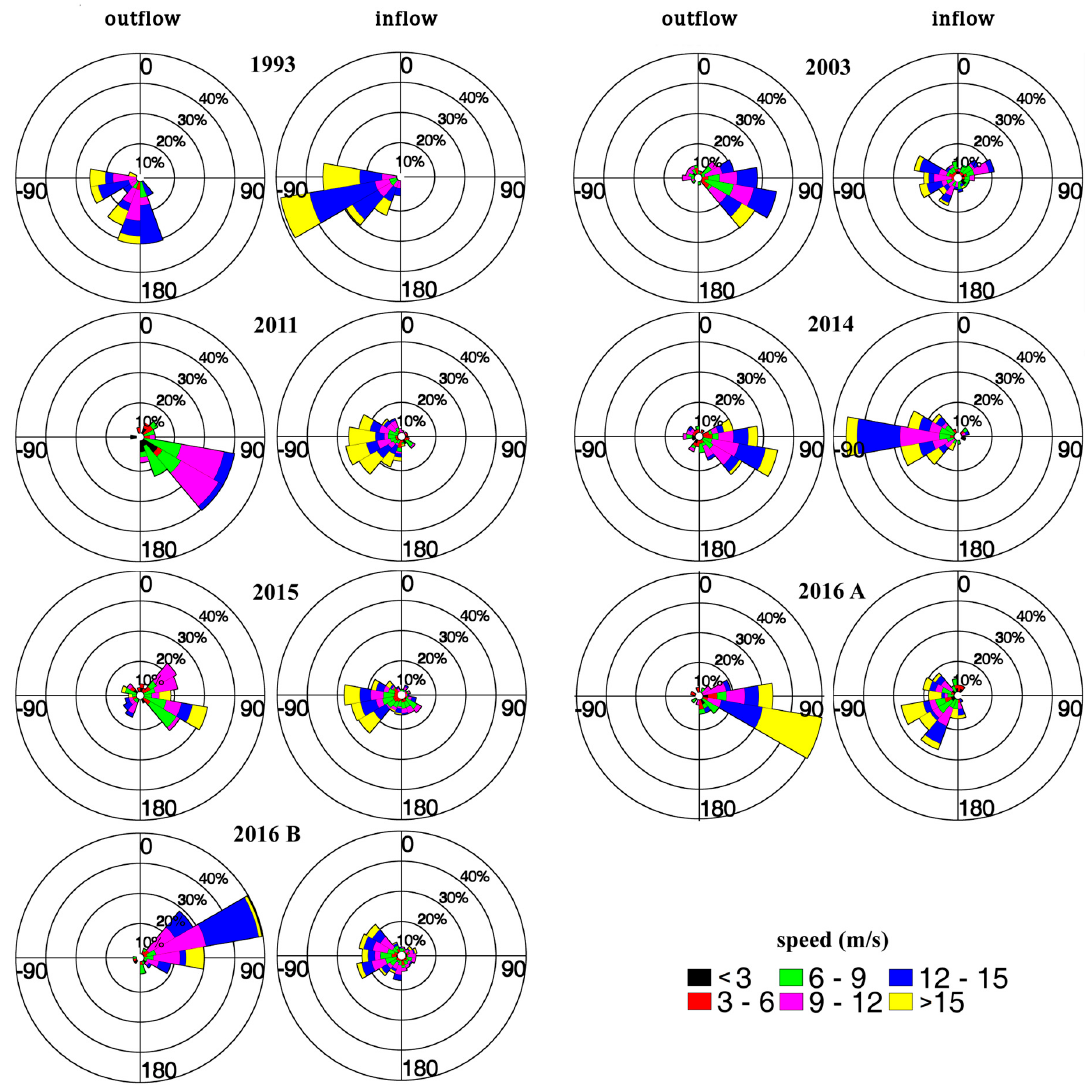
Figure 9. Wind roses summarizing wind conditions at pixel 1 (North Sea) for different MBI events. Each wind rose shows frequency of occurrence (in %) of different wind directions (according to the meteorological convention) and frequency of occurrence of wind speed values for a given direction. Solid black rings indicate the 10%, 20%, 30%, and 40%. Plots on the left side are for the outflow phase and on the right side for the inflow phase of each MBI event.